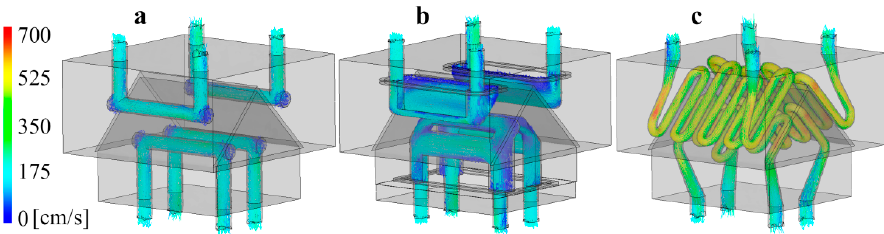
Figure 3. Flow velocity as a function of distance in the case of the ( a ) Conventional; ( b ) Milled multi- part; and ( c ) Conformal cooling